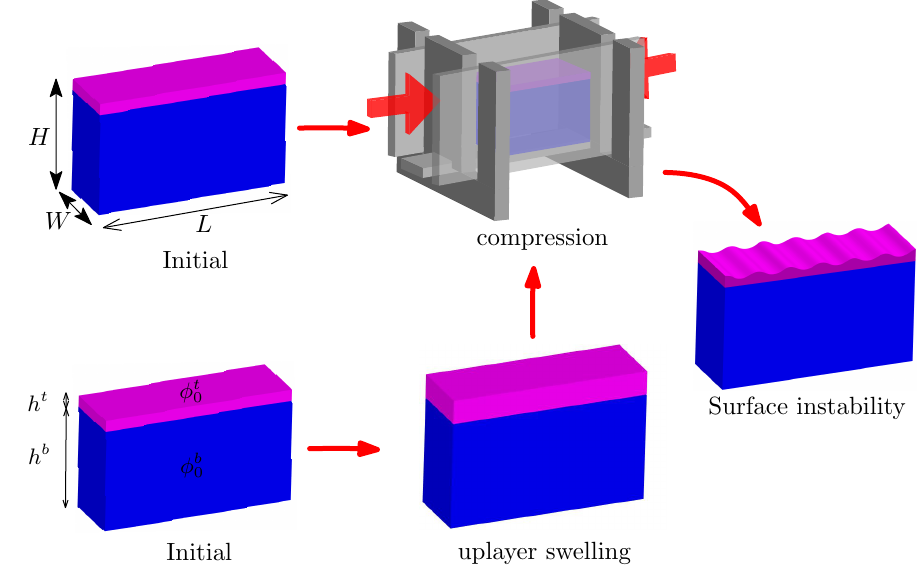
Figure 1. Schematics for two routes to realize the surface instability for the bilayer hydrogel discussed in the present work: (1) only mechanical compression after the fabrication of sample; (2) mechanical compression after the pre-absorption of water in the top